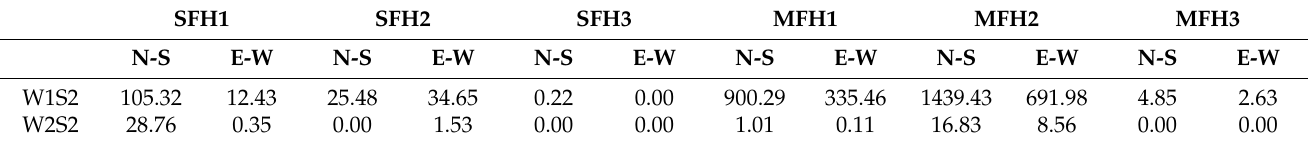
Table 14. Total primary energy savings per year (MW/h) of 2% of EVha building stock. SFH1 SFH2 SFH3